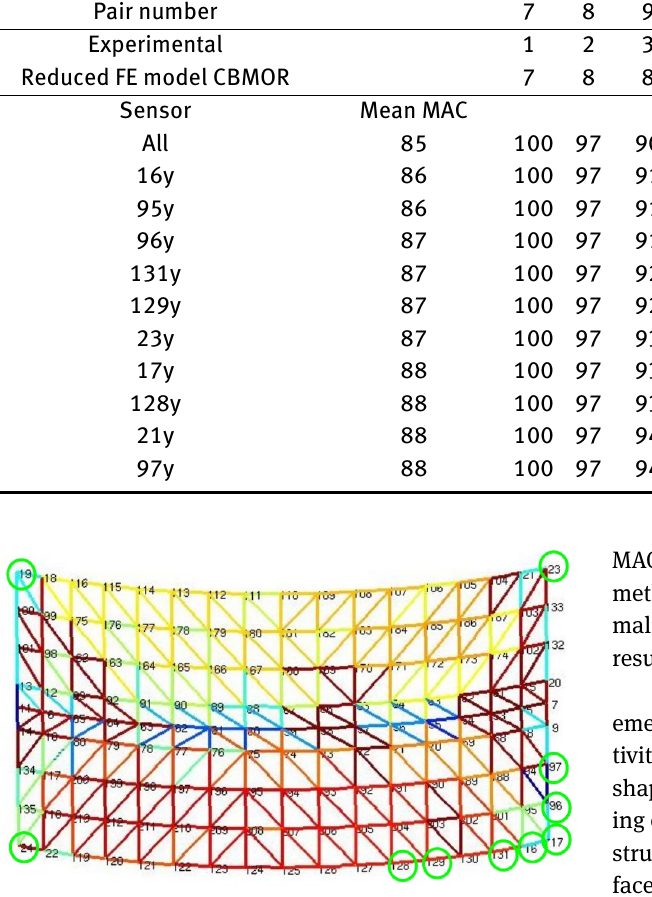
Figure 9: Identification of the “worst Y-sensors” (green) using